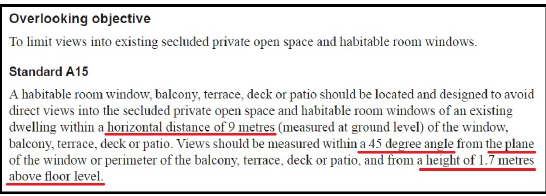
Figure 2. Overlooking description (adapted from Melbourne Planning Scheme Ordinance, clause